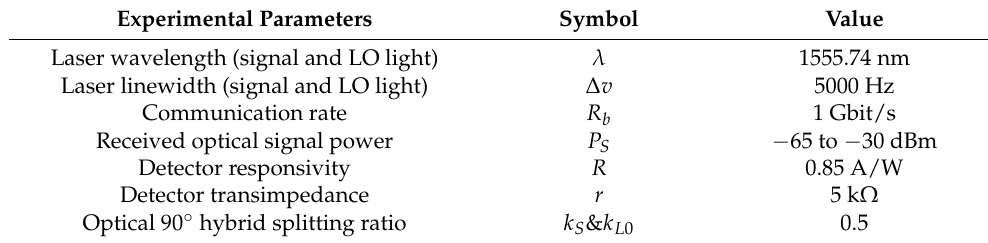
Table 1. Key experimental parameters.